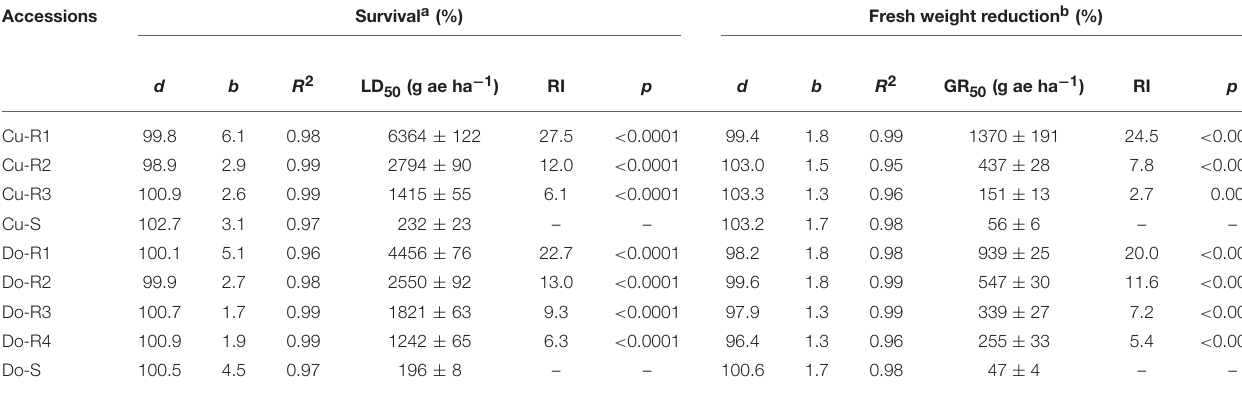
TABLE 2 | Parameters of the log-logistic equations used to calculate the glyphosate rates required for 50% survival (LD 50 ) and reduction fresh weight (GR 50 ) of the different accessions of P. hyterophorus from Cuba and Dominican Republic. Accessions